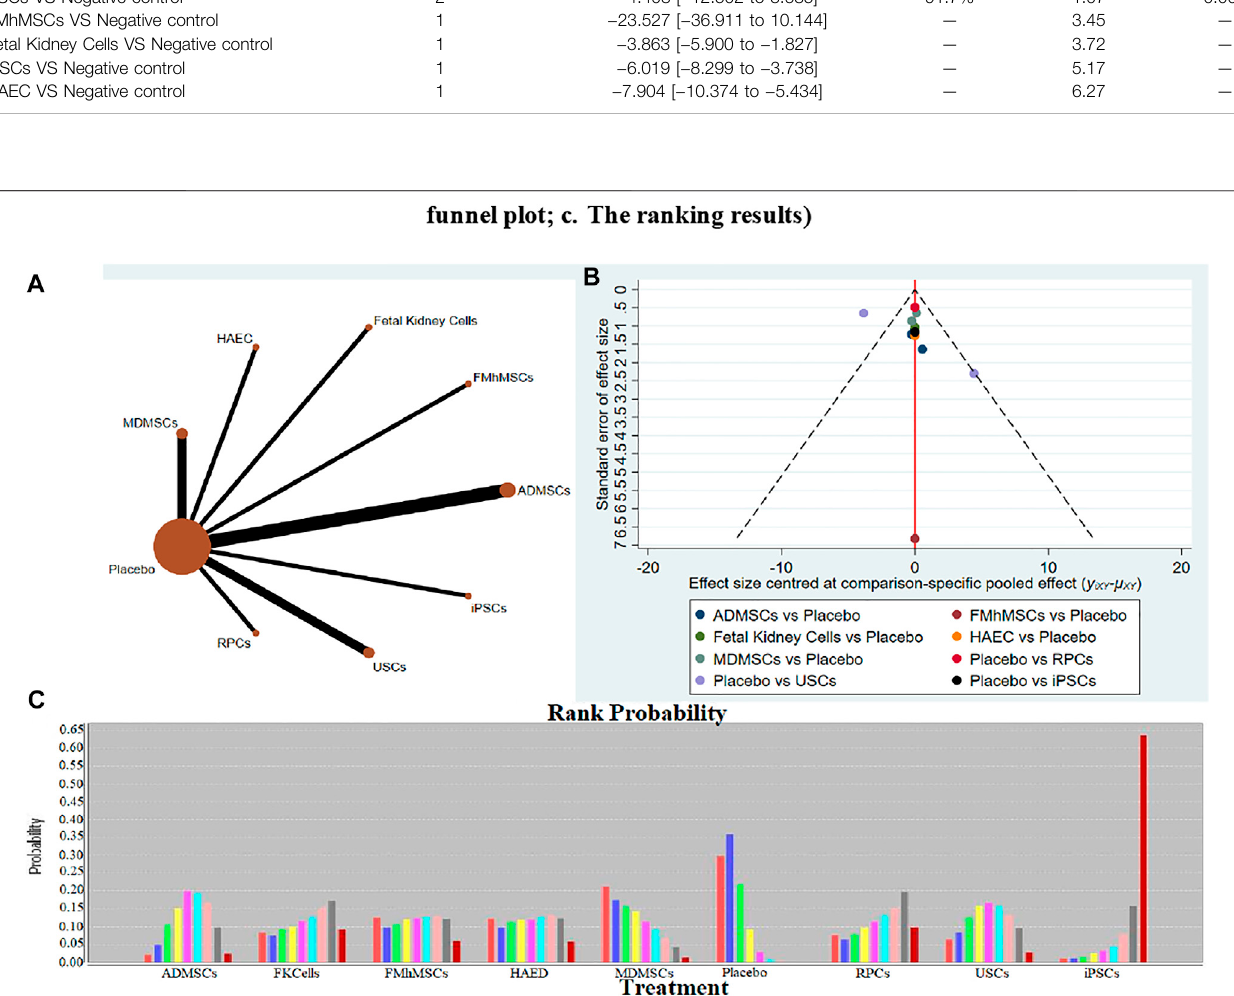
Frontiers in Pharmacology |